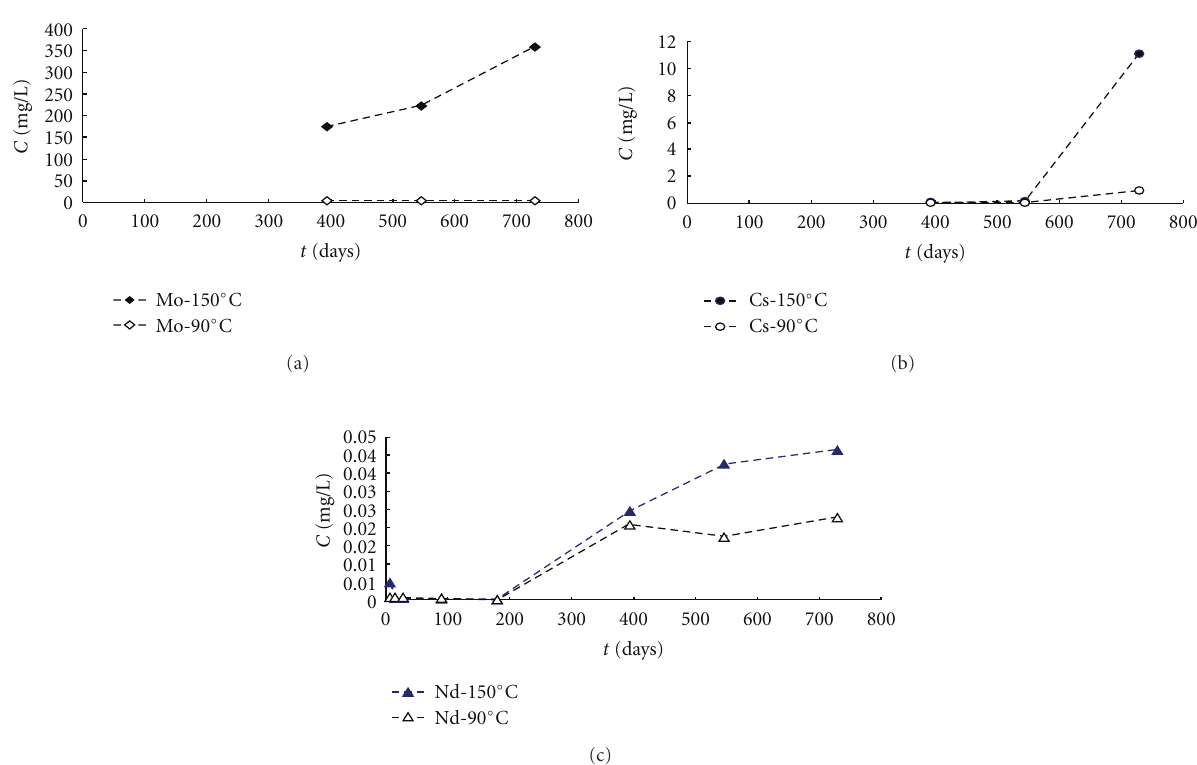
Figure 3: The leaching of radionuclide surrogate